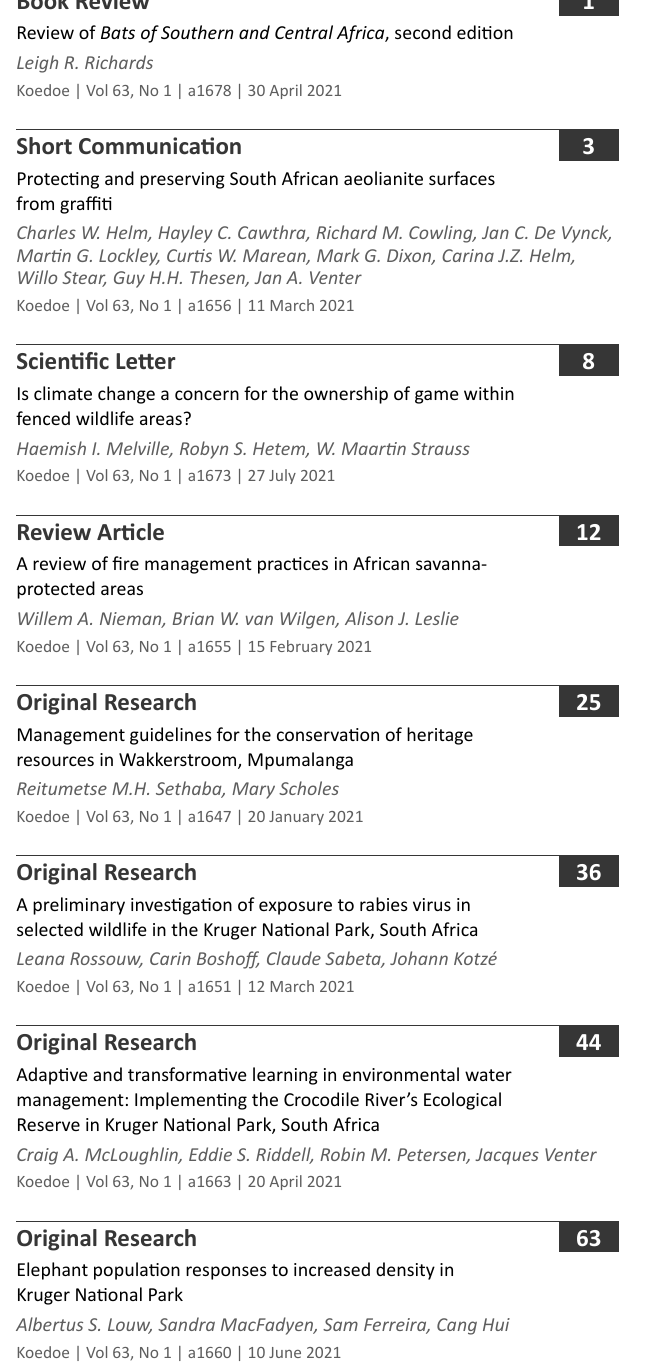
Mammals in the mountains: An historical review and updated checklist of the mammals of the Mountain Zebra National Park Daniel M.